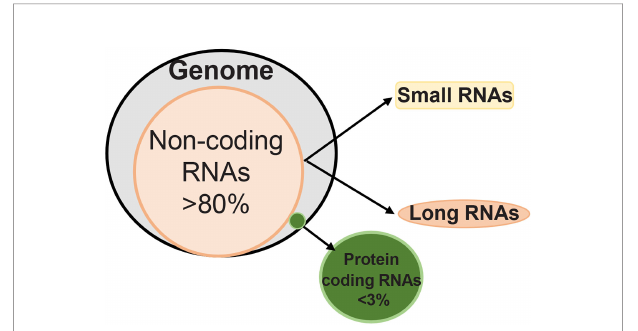
FIGURE 1 | Human genome has less than 3% RNAs that can code for proteins, and over 80% of RNAs are noncoding. Depending on the length of their transcripts, noncoding RNAs are classi fi ed as ‘ small ’ and ‘ long ’ noncoding RNAs. While small noncoding RNAs have less than 200 nucleotides, long noncoding RNAs have over 200 nucleotides.